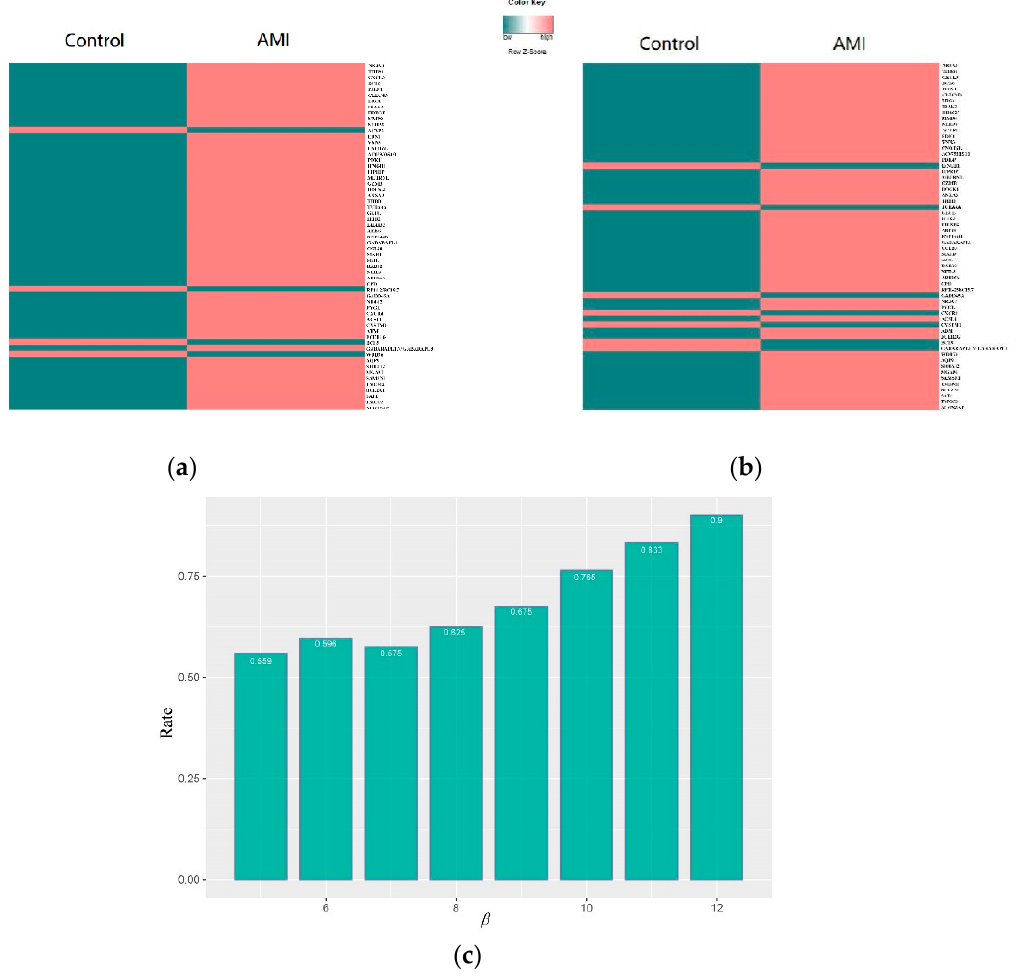
Figure 3. ( a ) Gene expression; ( b ) gene control capability; ( c ) proportion of genes with a control β capability above that have been confirmed to be directly related to AMI/MI. Table 1. Category of DCCGs.